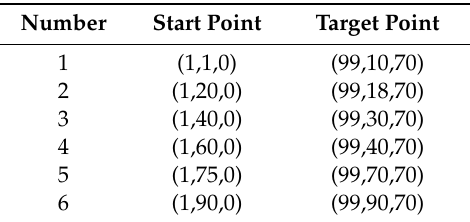
Table 13. Coordinates of the starting and target points of all UAVs (case 3).